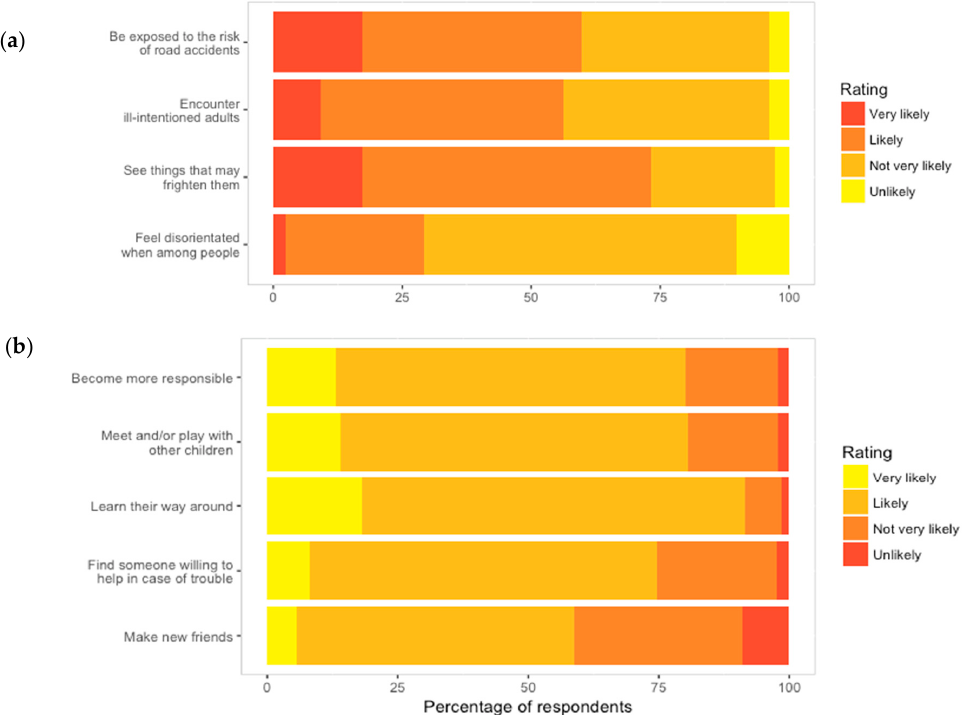
Figure 4. Responses to items from the Perception of Positive Potentiality of Outdoor Autonomy for Children (PPOAC) scale. ( a ) Negative statements and ( b ) positive statements.